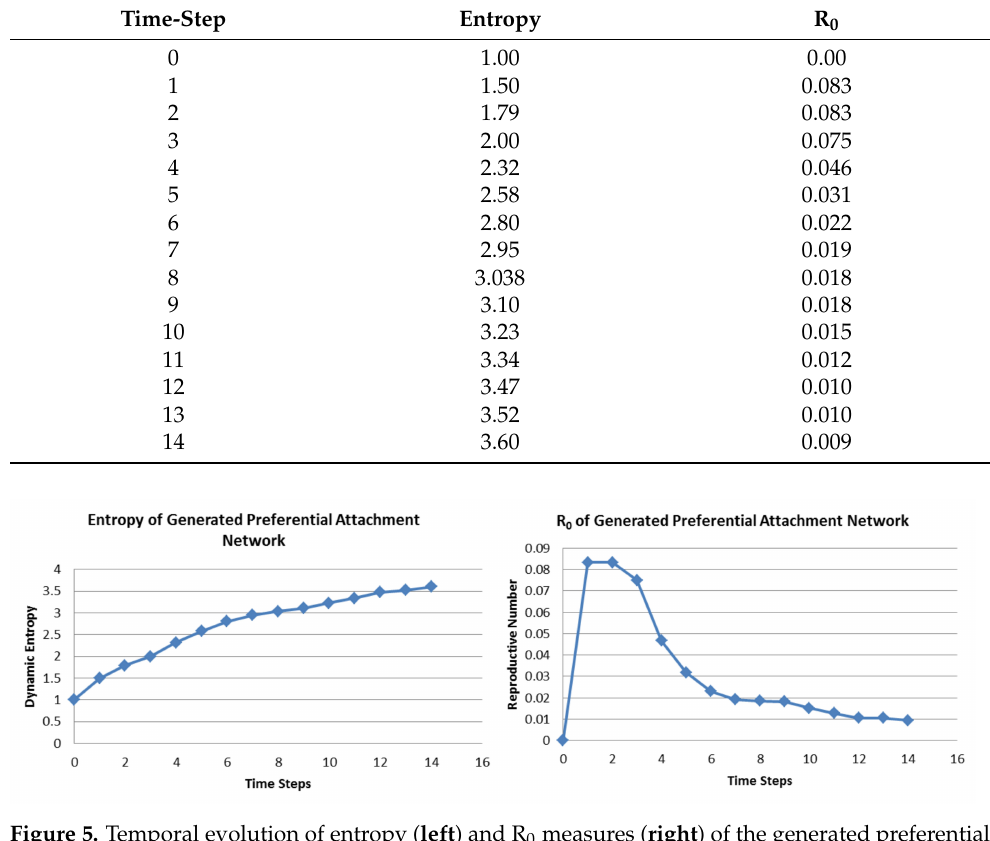
Figure 5. Temporal evolution of entropy ( left ) and R 0 measures ( right ) of the generated preferential attachment